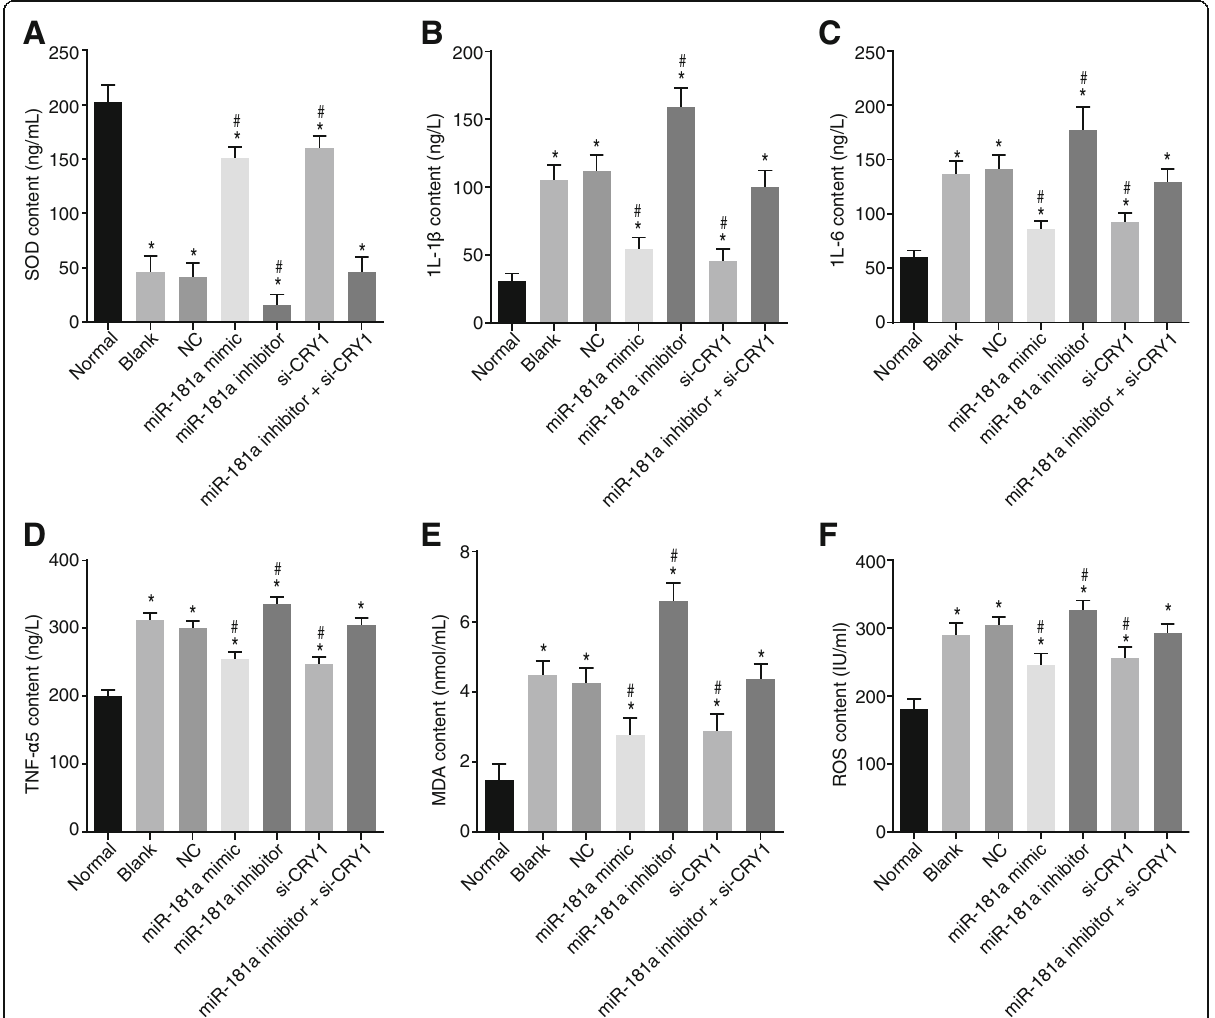
Fig. 3 ELISA indicates that serum SOD, ROS, MDA, IL-1 β , and IL-6 are decreased while TNF- α is increased after transfection of miR-181a or si-CRY1. Notes: Panel a , histogram of SOD; Panel b , histogram of IL-1 β ; Panel c , histogram of IL-6; Panel d , histogram of TNF- α ; Panel e , histogram of MDA; Panel f , histogram of ROS; * , p < 0.05 vs. the normal group; # , p < 0.05 vs. the blank and NC groups; the data are presented as the mean ± standard deviation, analyzed by one-way ANOVA; the experiment was independently repeated three times; NC, negative control; miR-181a, microRNA-181a; CRY1, cryptochrome 1; SOD, superoxide dismutase; MDA, malondialdehyde; ROS, reactive oxygen; IL-6, interleukin-6; IL-1 β , interleukin-1 β ; TNF- α , tumor necrosis factor-